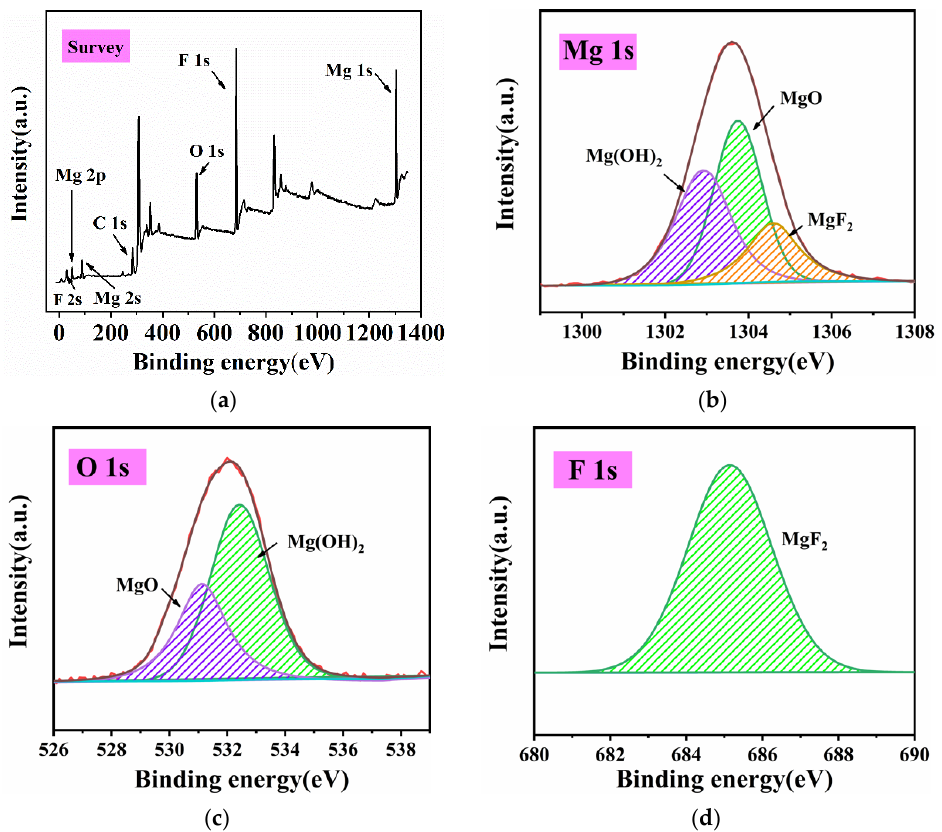
Figure 2. ( a ) XPS survey spectra; ( b ) XPS spectra of Mg 1s core level regions; ( c ) XPS spectra of the O 1s core level regions; ( d ) XPS spectra of F 1s core level regions.